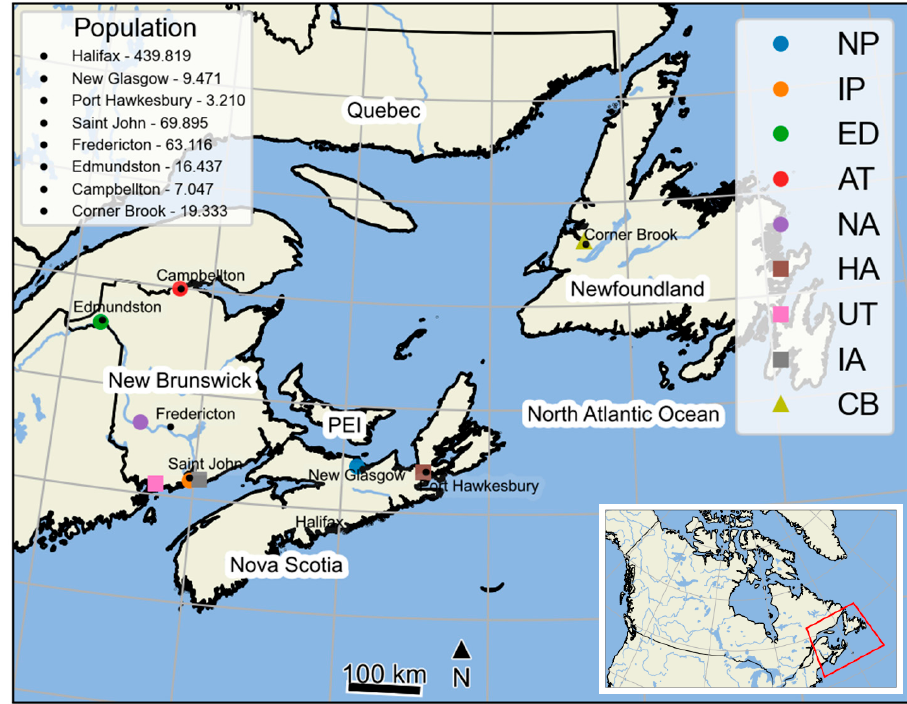
Figure 1. Location of mills and major populated centres. Pulp mills are represented with a circle, paper mills with a square, and the pulp and paper mill with a triangle. Table 2. Location of Atlantic Canadian pulp and/or paper mills and their characteristics. PA: Paper; PU: Pulp; PP: Pulp and Paper.